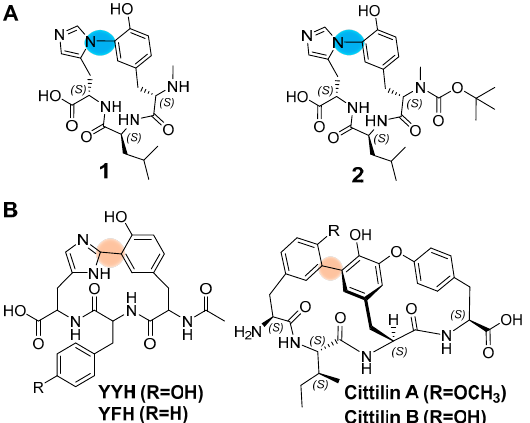
Figure 1. Chemical structures of the myxobacterial biarylitide MeYLH termed Myxarylin ( 1 ) and its semi-synthetic Boc derivative Myxarylin-Boc ( 2 ) ( A ). Biosynthetically characterized members of the biarylitide family such as biarylitide YYH and YFH originating from Planomonospora spp., and cittilin A and B ( B ). Blue circles indicate C–N biaryl bonds and the beige-colored circle indicates the C–C biaryl bond.